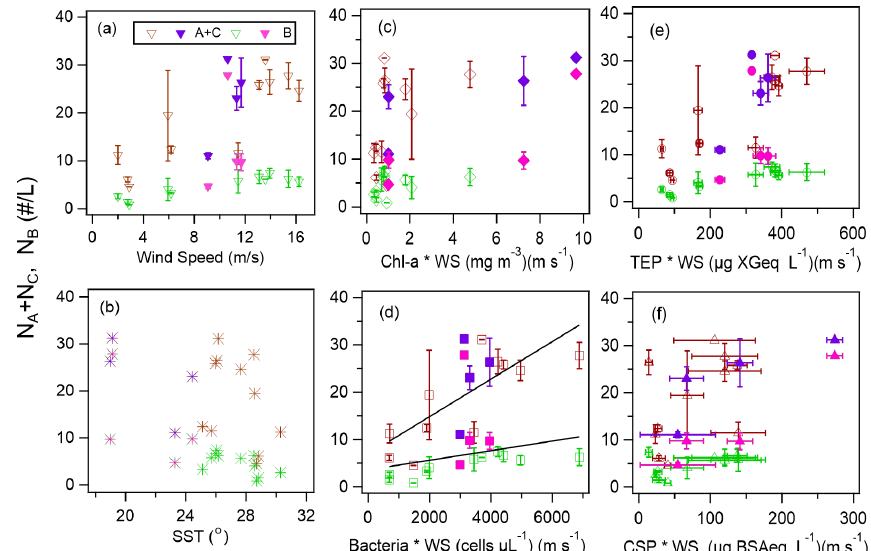
Figure 8. Number concentrations of Type A + C and Type B particles and (a) wind speed, (b) SST, (c) product of wind speed (WS) and Chl- a concentration, (d) product of WS and bacteria concentration, (e) product of WS and TEP concentration, and (f) product of WS and CSP concentration. Open markers indicate Period 1, and solid markers indicate Period 2. The black lines in Fig. 8d represent the orthogonal regression lines for all Type A + C data and for all Type B data as an example. The error bars represent 1 standard deviation.